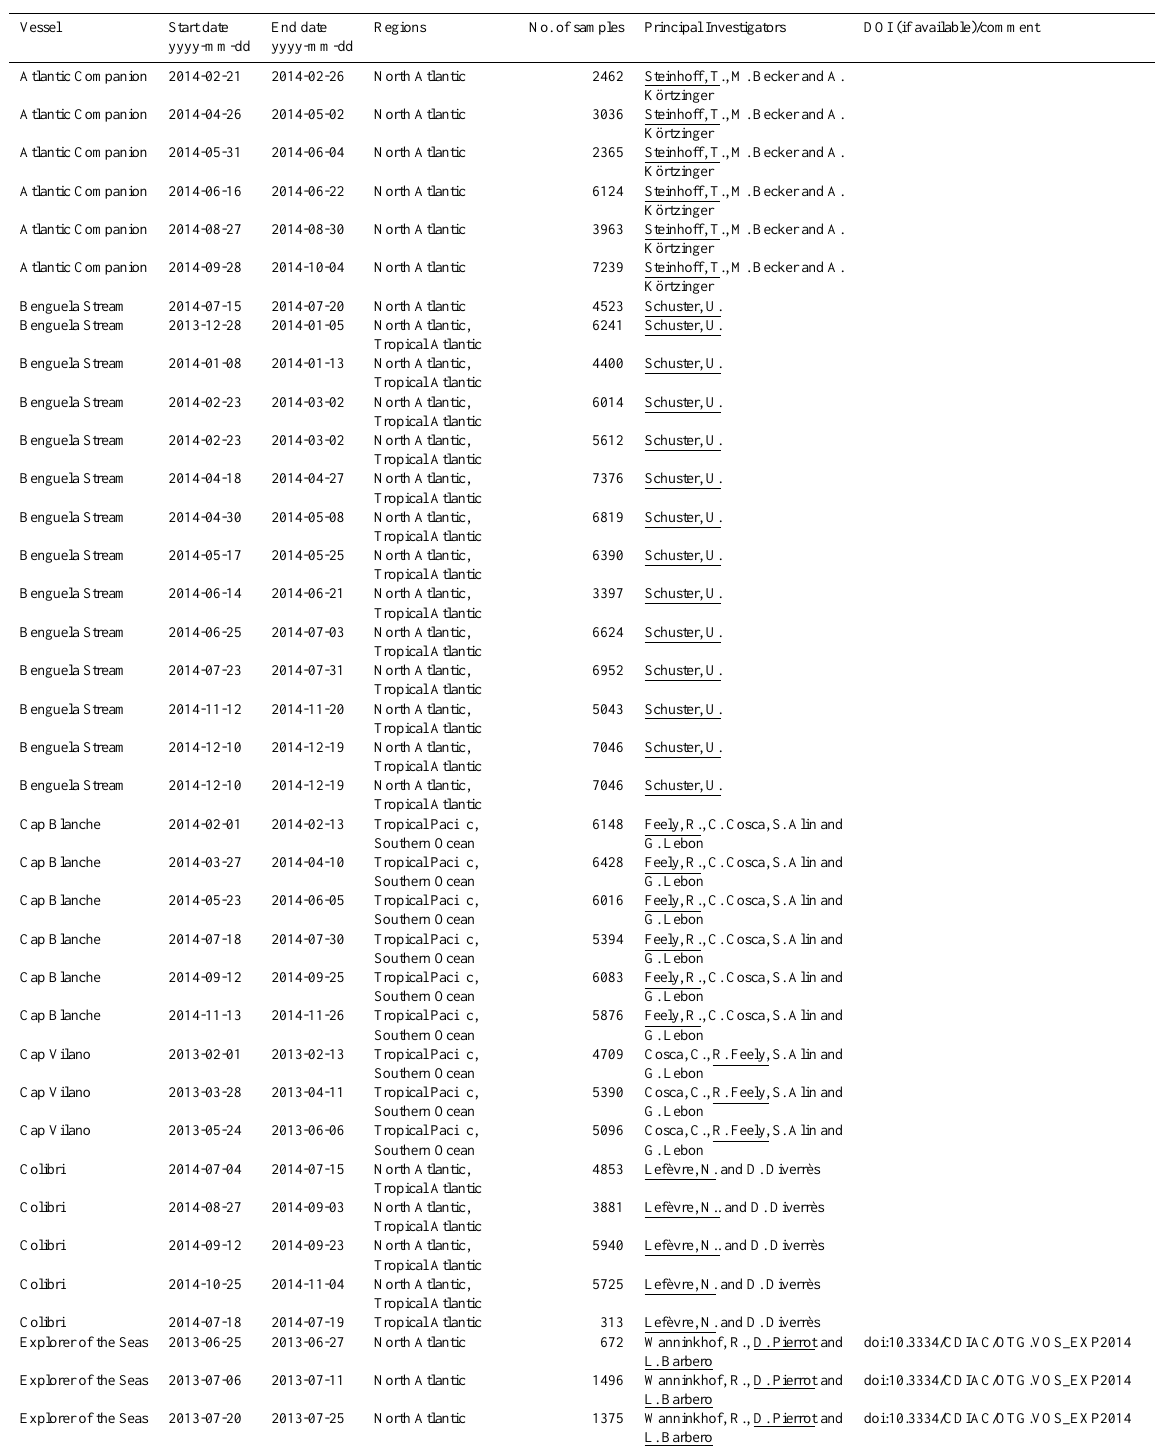
Table A1. Attribution of fCO 2 measurements for years 2013–2014 used in addition to SOCAT v3 (Bakker et al., 2014, 2015) to inform ocean data